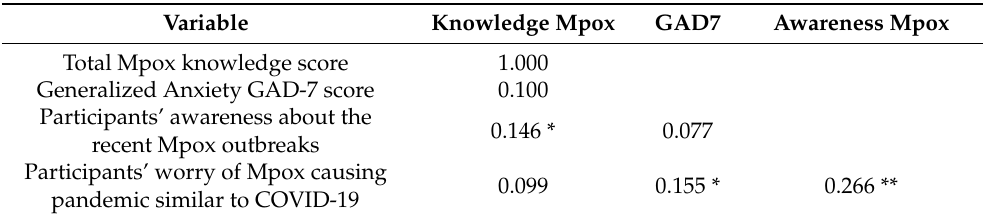
Figure 6. Participants’ perceptions about the similar symptoms of COVID-19 and Mpox. Table 4 explains the bivariate correlation between participant’s overall Mpox disease knowledge score and their other measured perceptions. The knowledge score correlated significantly but weakly and positively with their awareness about the recent outbreaks of Mpox disease (rho = 0.146, p -value < 0.050), while it did not correlate with their worry about the Mpox causing a pandemic similar to COVID-19. On the other hand, their worry about Mpox disease causing a pandemic correlated significantly and positively but weakly with their GAD7 score (rho = 0.155, p -value = 0.050). Logically, their awareness of the recent outbreaks of Mpox disease corelated positively and with high significance with their worry about Mpox disease causing a pandemic (rho = 0.266, p -value < 0.010). Table 4. Bivariate Spearman’s correlations (Rho) test between the HCW’s measured perceptions and knowledge about Mpox.